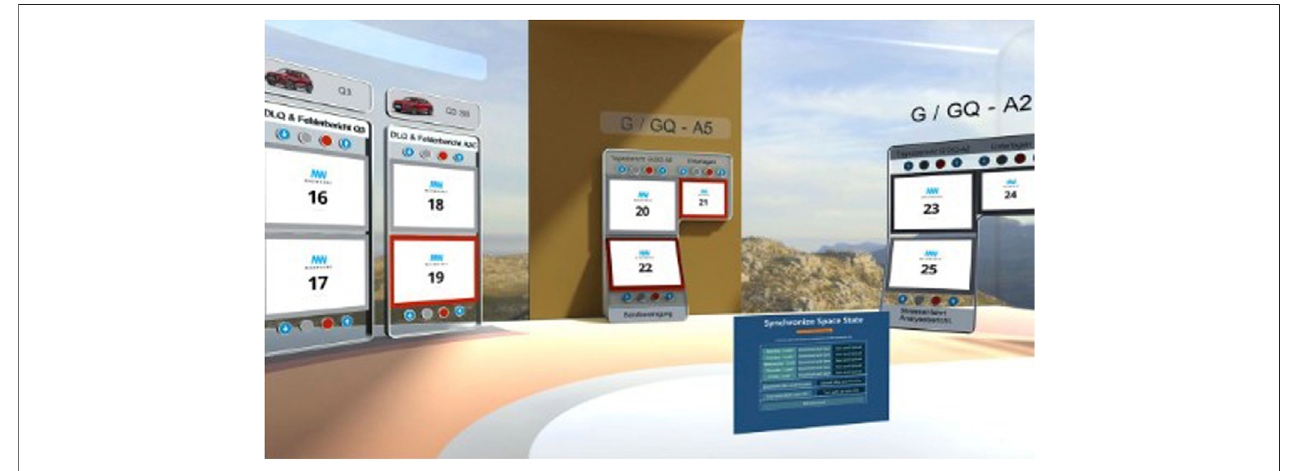
FIGURE 1 | Visual supported smartboards in MaxWhere 3D